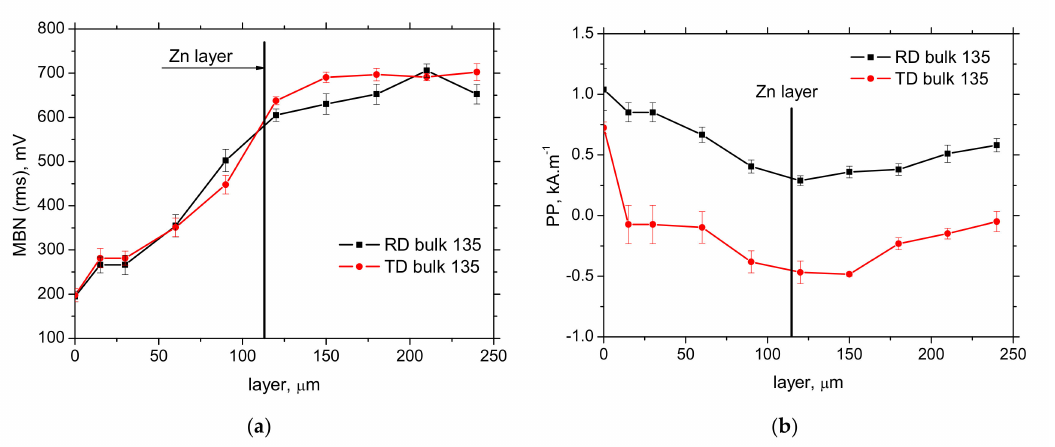
Figure 14. Evolution of MBN and PP after the consecutive removal of Zn layer (sample of the nominal thickness of Zn layer indicated by the OM 112 ± 3 µ m). ( a ) MBN, ( b ) PP